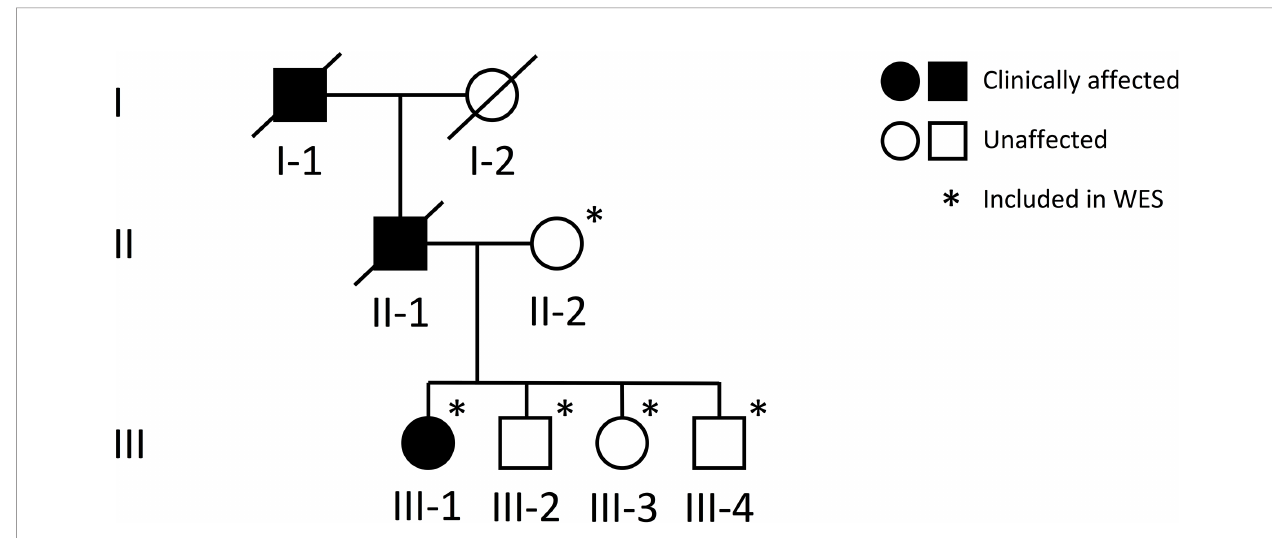
FIGURE 1 | Pedigree of a Finnish family with a novel TBX2 missense variant p.Thr300Met. Squares represent males, circles females, black symbols clinically affected family members, white symbols clinically unaffected family members, and slashes deceased family members. Generations are numbered with roman numerals. Individuals included in WES analysis are indicated with an